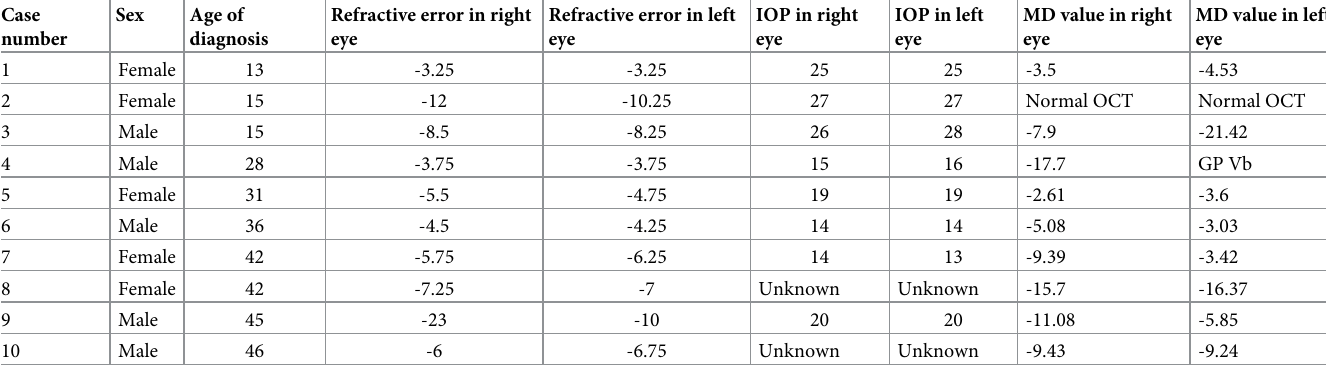
Table 1. Demographic information and ocular characteristics of the